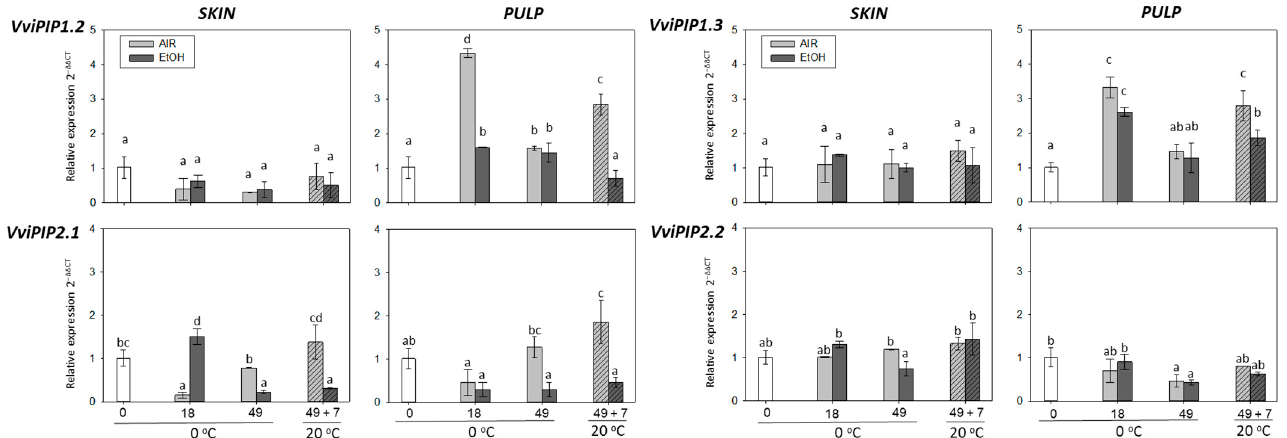
Figure 6. Effect of low temperature and ethanol treatment on aquaporins gene expression ( PIP1.2, PIP1.3, PIP2.1 , and PIP2.2 ) in the skin and pulp of It 681–30 table grapes stored for 49 days at 0 ◦ C and after the shelf-life period (49 d + 7 d at 20 ◦ C). The transcript levels of each gene were assessed by RT-qPCR and normalized using Actin1 as a reference gene. The results were calculated relative to a calibrator sample (time 0) using the formula 2 − ∆∆ Ct . Values are the mean ± SD, n = 6. Different letters on bars indicate that the means are statistically different using the Tukey-b test ( p < 0.05). Table 4. Pearson correlation between aquaporins from the skin (S) or the pulp (P) of non-treated and ethanol-treated It 681–30 table grapes stored at low temperature and after the shelf-life period.